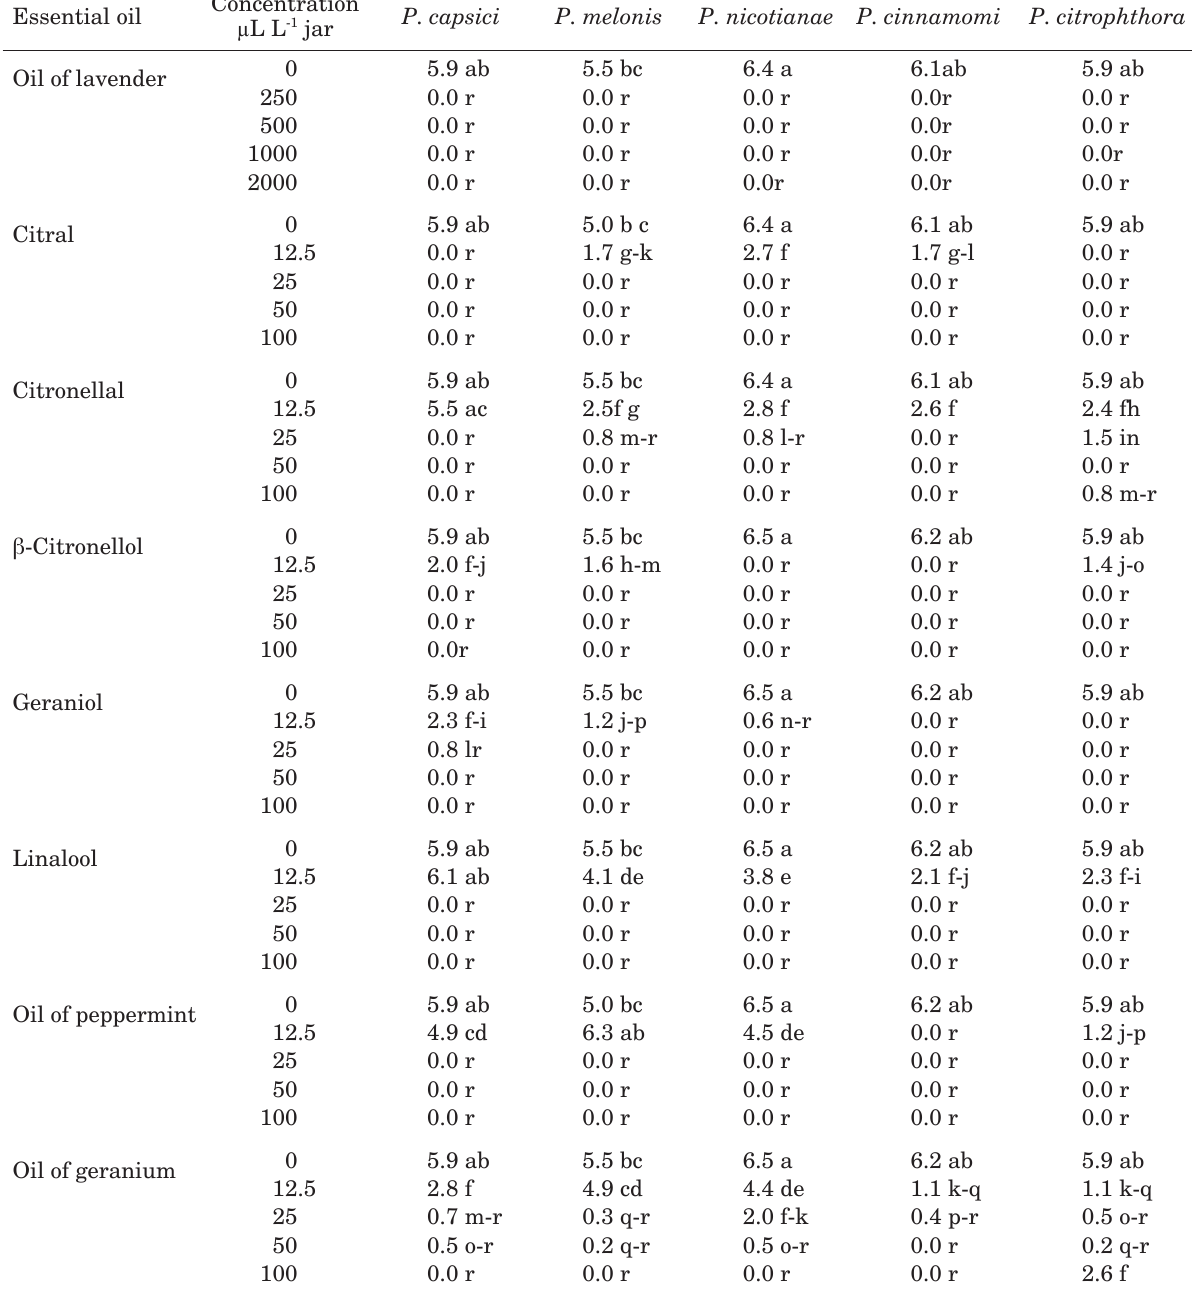
Table 4. Mean colony growth rates (mm day -1 ) (fumigant effect) for different Phytophthora spp. exposed to different essential oils a